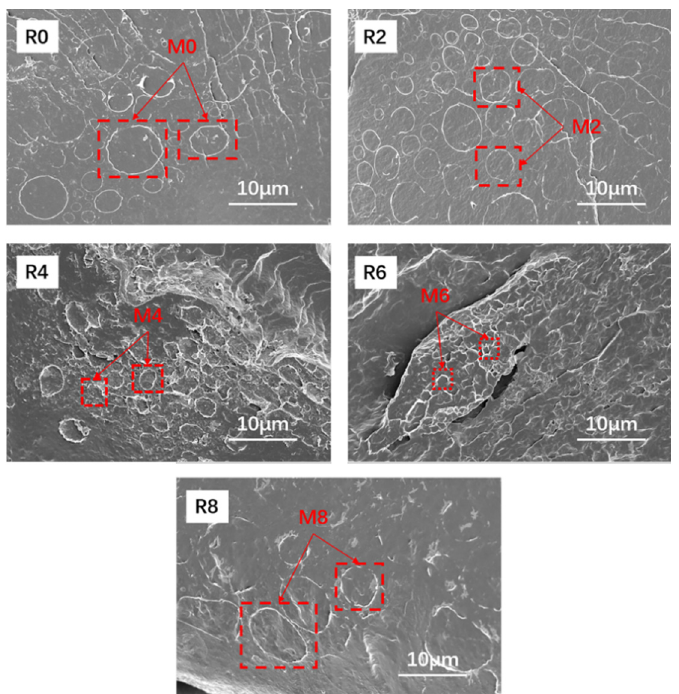
Figure 9 . SEM images of the vulcanizates after etching of the resins. Figure 9. SEM images of the vulcanizates after etching of the resins.